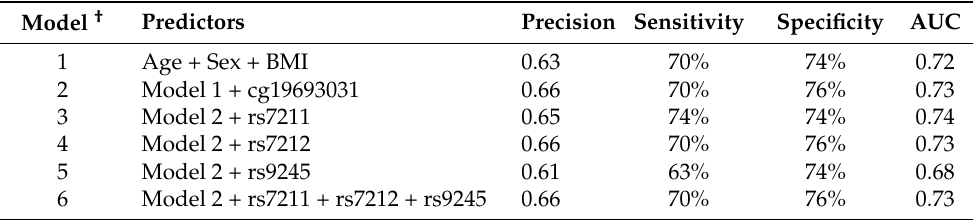
Table 10. Performance metrics of logistic regression models for predicting normoglycemic vs. diabetic subjects ( A ), normoglycemic vs. prediabetic subjects ( B ) and prediabetic vs. diabetic subjects ( C